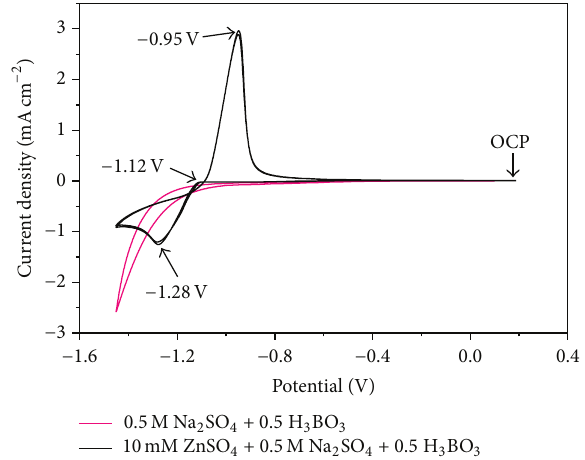
Figure 2: Cyclic voltammograms of GaN electrode at the scan rate of 10 mVs −1